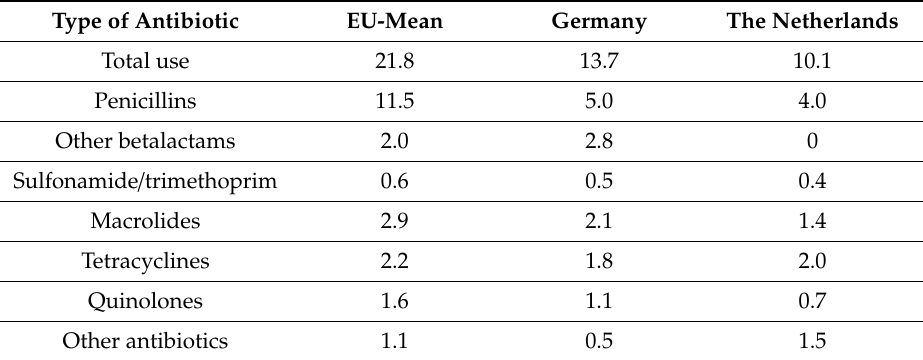
Table 2. Antibiotic use among outpatients in defined daily doses (DDD) per 1000 inhabitants per day in 2017